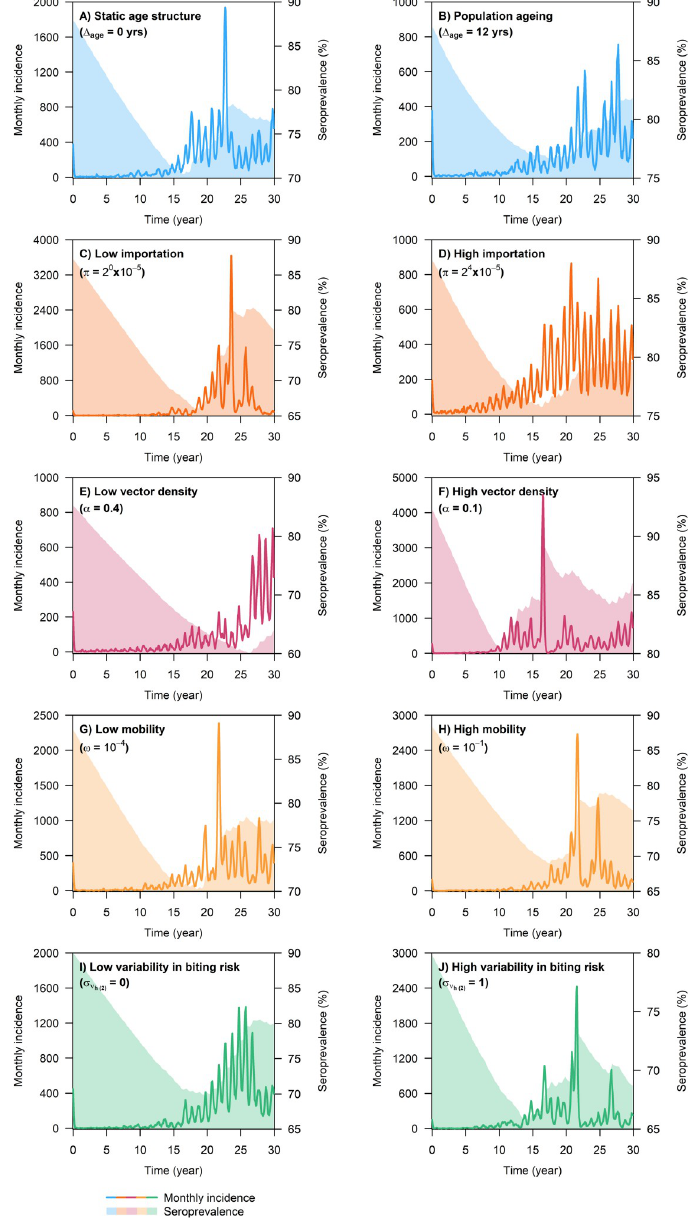
Fig 2. Simulated monthly number of dengue infections and dengue seroprevalence following a permanent reduction in the mosquito population size by 70% in different dengue endemic settings. Unless otherwise stated, model parameters were fixed at the following values: π = 4 × 10 − 5 , ω = 0.005, ρ = 0, s 180, p RM = 0.7, σ RM = 0 (Here we used σ RM = 0 to denote spatially uniform vector control